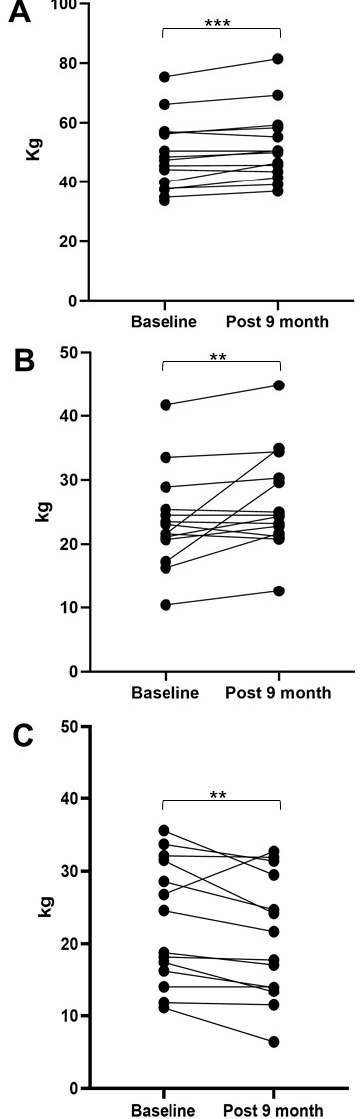
Figure 1. Body composition at the baseline and after 9 months of treatment with patisiran. Panel ( A ) represents individual patient data for FFM: free fat mass; Panel ( B ) represents the individual patient data for BCM (body cell mass); Panel ( C ) represents the individual patient data for FM (fat mass). ** p < 0.05; *** p < 0.01.